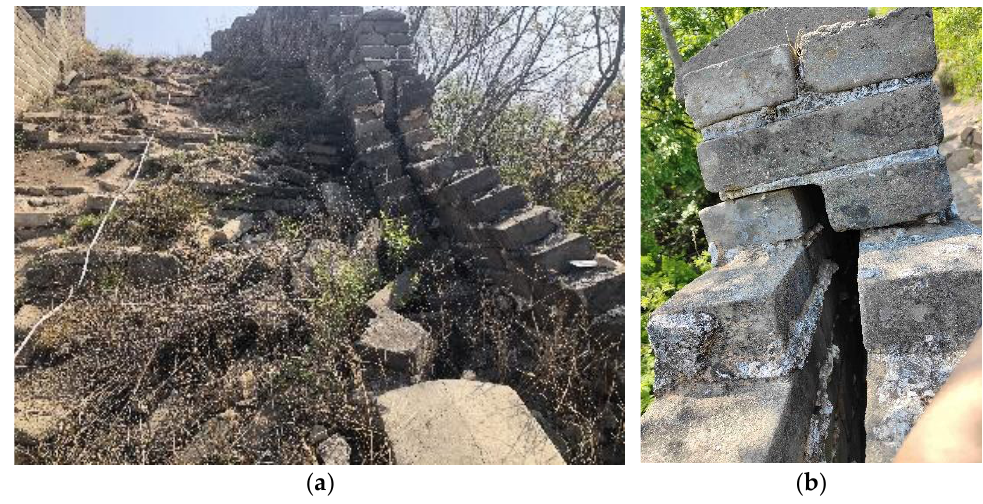
Figure 8. Parapet failures ( a ) Gradual collapse; ( b ) Wythe detachment.